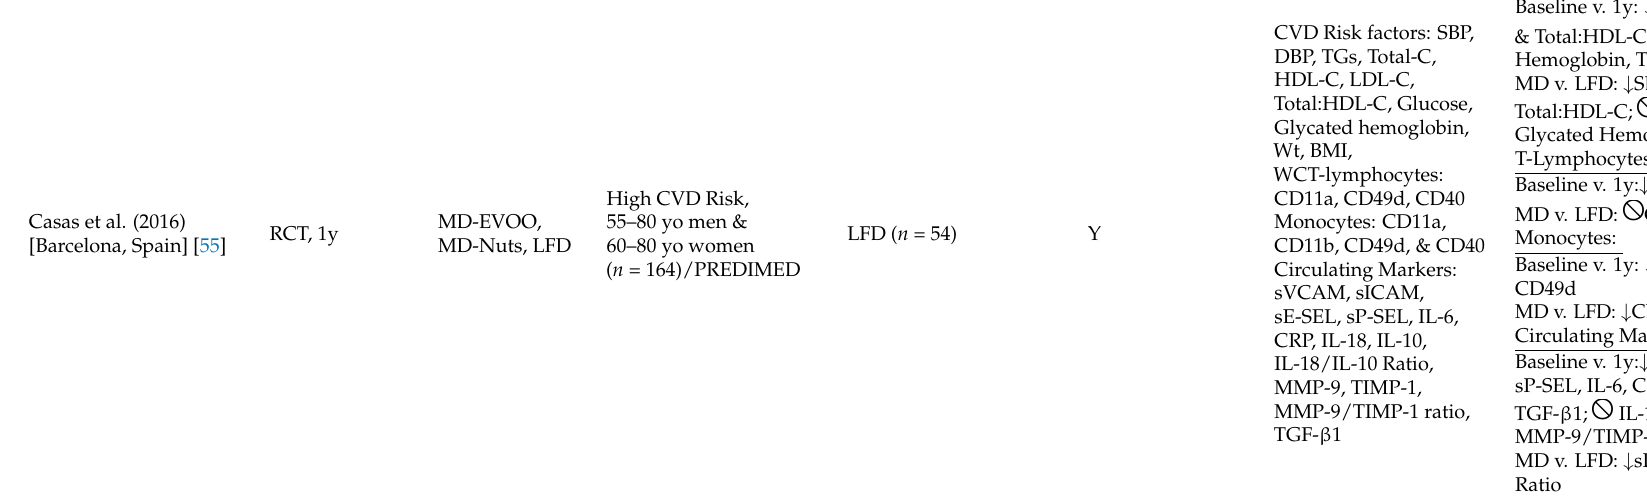
Table 2. Clinical